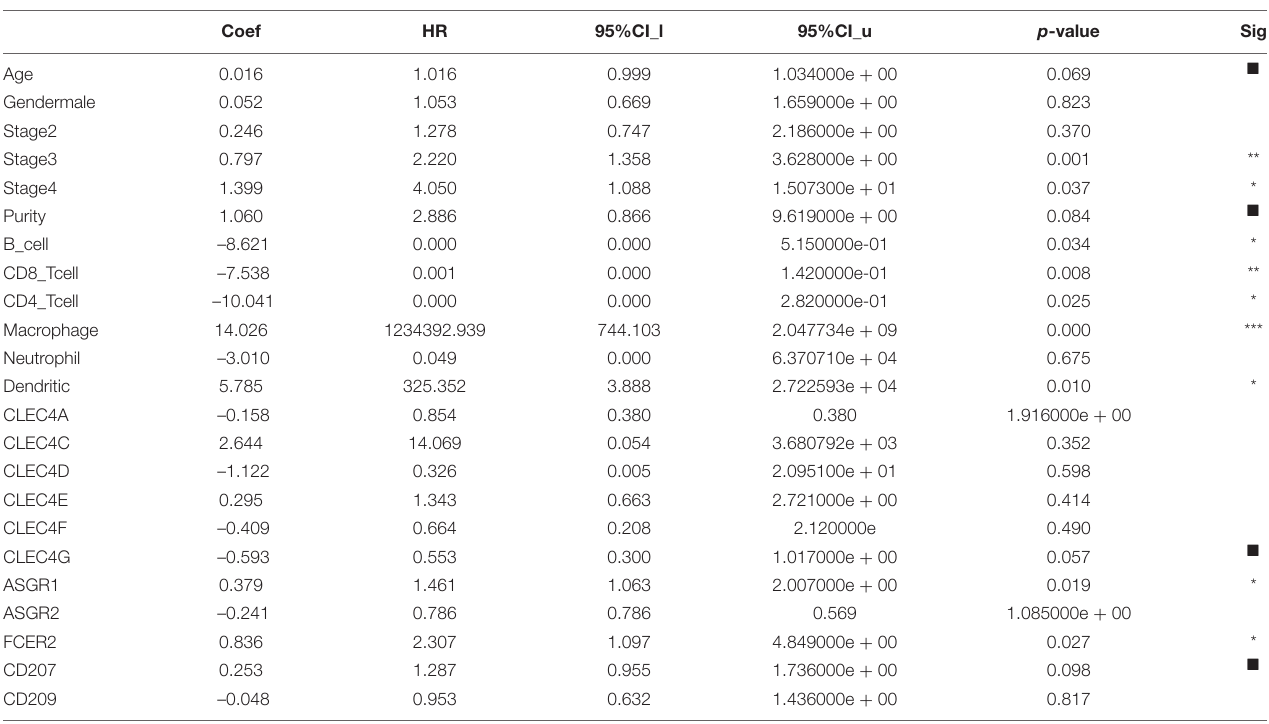
TABLE 3 | Multivariate analysis of overall survival in 315 LIHC patients.